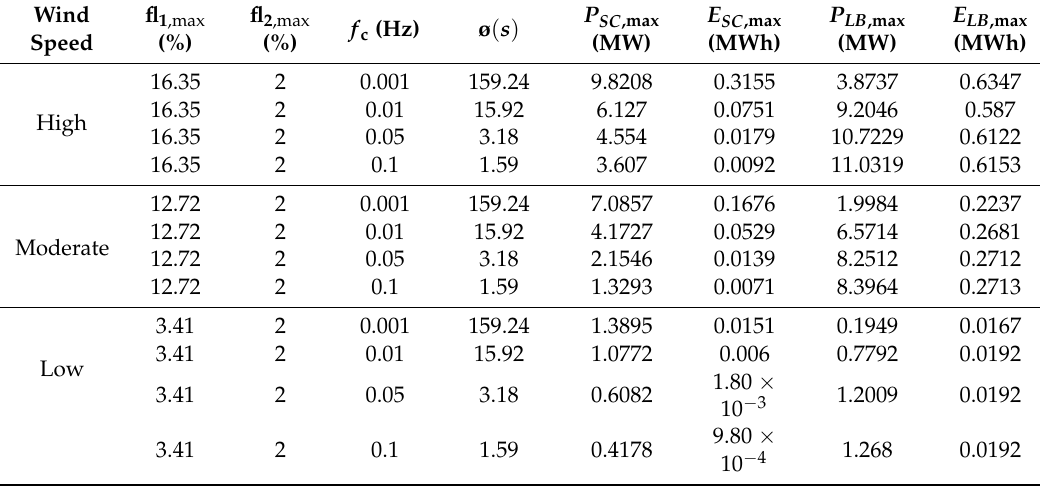
Table 5. Energy storage power and energy requirement with different wind speed conditions and COF. γ 1 : Fluctuation ratio of wind power; γ 2 : Fluctuation ratio limit; P sc ,max : Maximum power of supercapacitor; P LB ,max : Maximum power of Li-ion Battery; E sc ,max : Maximum energy of supercapacitor; E LB ,max : Maximum energy of Li-ion